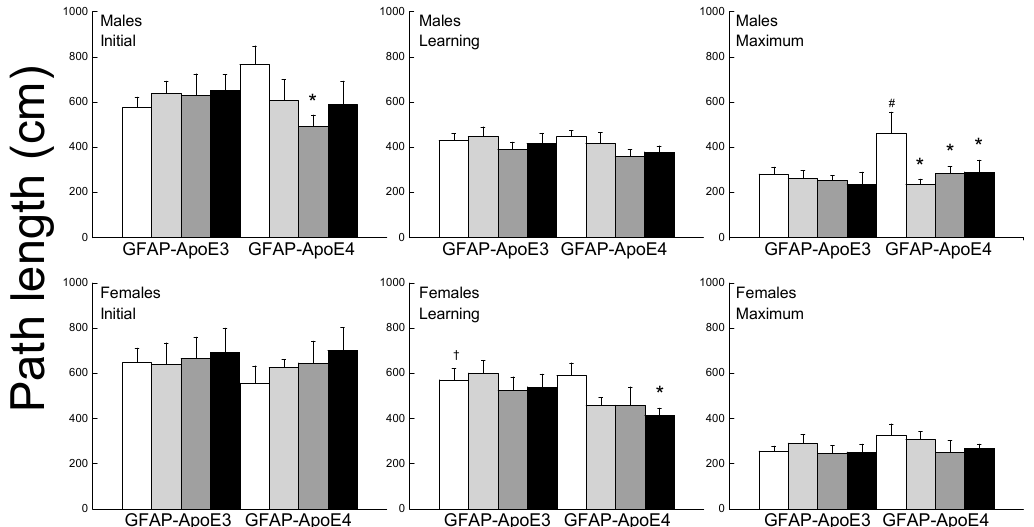
Figure 4. Exercise and antioxidants were associated with mild improvement in swim maze performance in male GFAP-ApoE4 mice but not in GFAP-ApoE3 mice. Each value represents mean ± SEM, n = 5–16. * p < 0.05 vs. sex- and strain-matched Sed-Con groups; # p < 0.05 comparing sex-matched Sed-Con GFAP-ApoE3 and GFAP-ApoE4 mice; † p < 0.05 comparing strain-matched Sed-Con males and Sed-Con females.